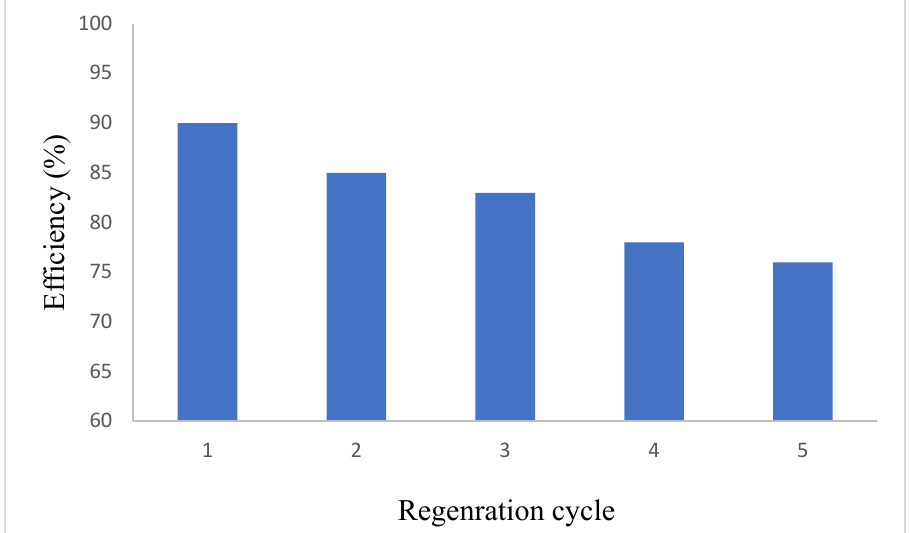
Figure 5. Decrease in percent efficiency of iron removal for consecutive 5 cycles .